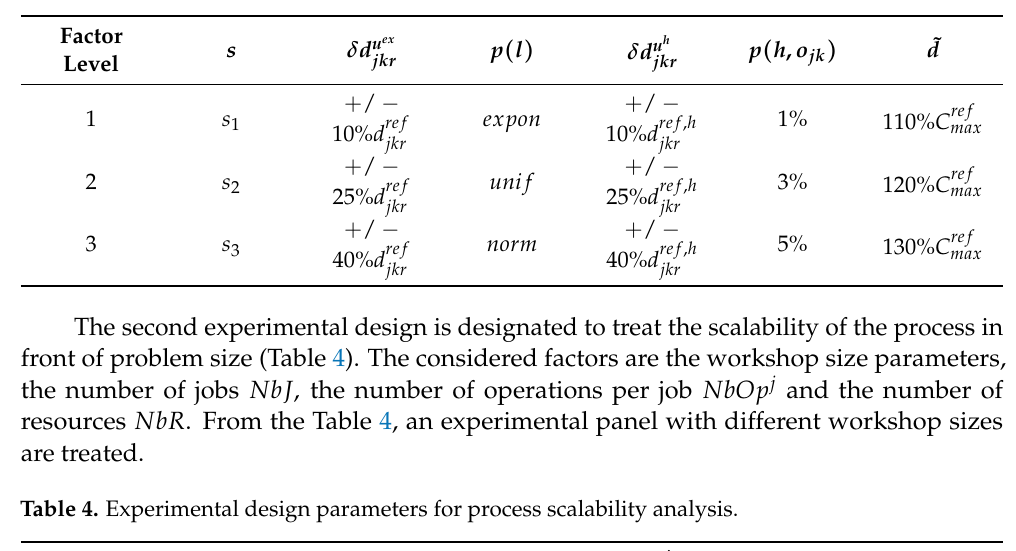
Table 3. Experimental design parameters for process sensitivity analysis.